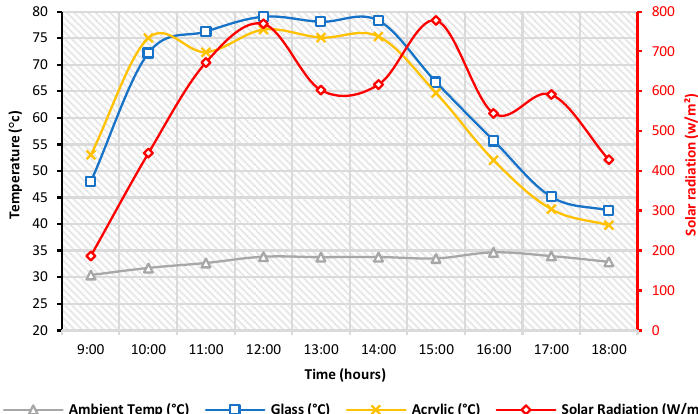
Figure 10. Variation in solar intensity and temperature of desiccant materials on 21 February 2020.